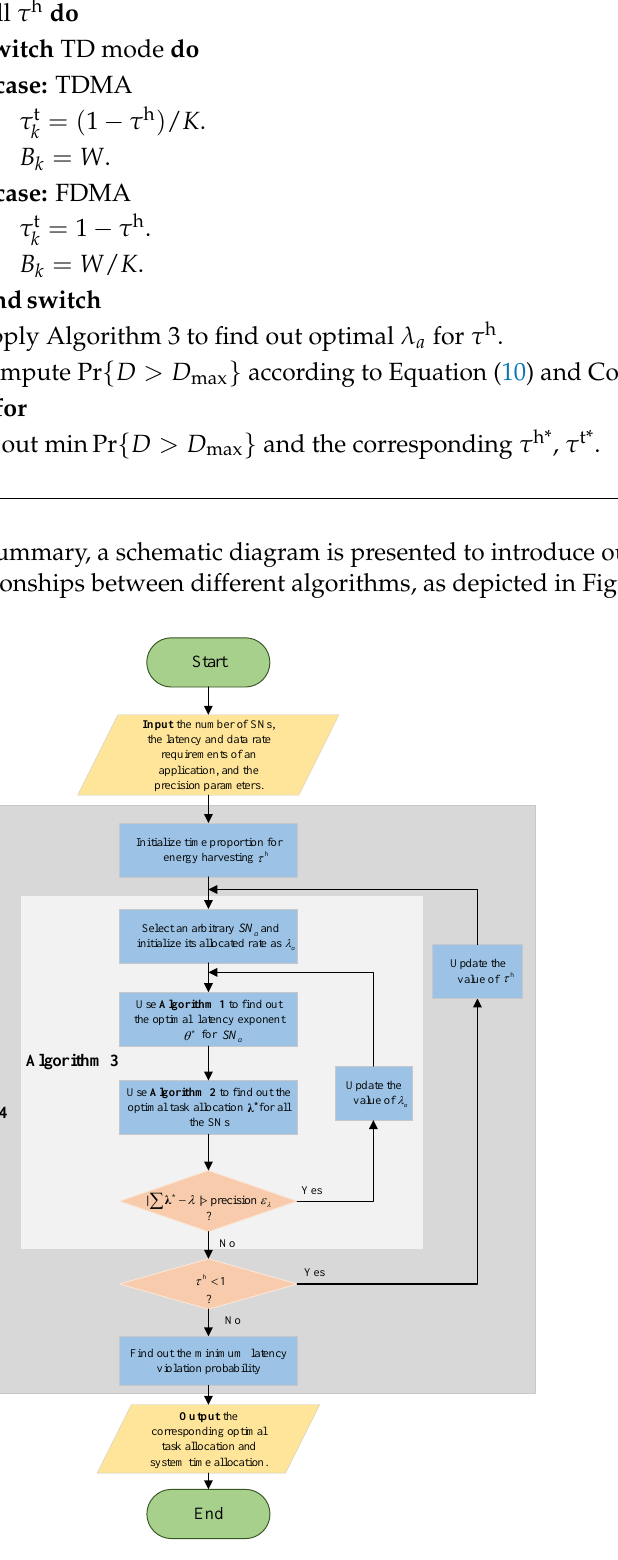
Figure 3. The schematic diagram of the overall